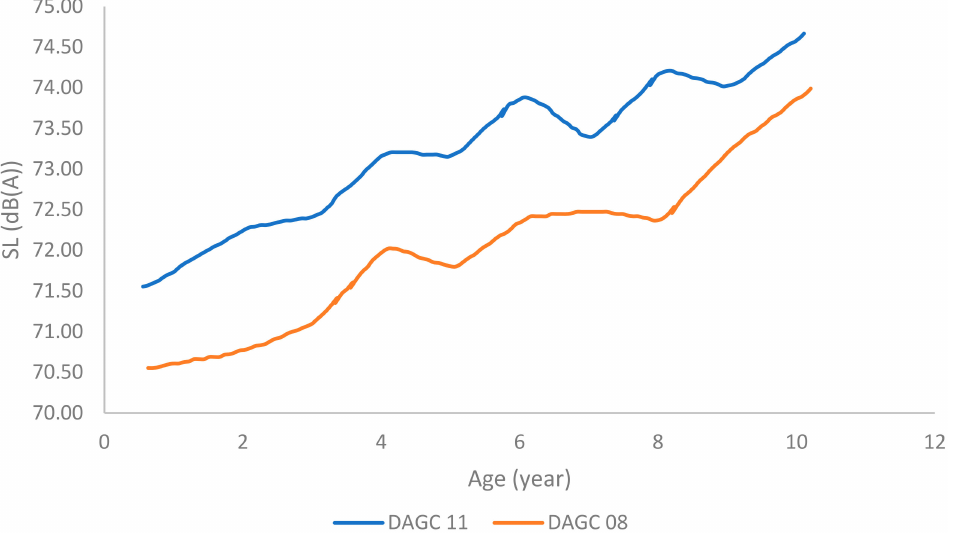
Figure 14. Noise evolution over time for a passenger car at 60 km/h for dense-graded asphalt concrete with 11 mm and 8 mm maximum aggregate sizes (adapted from